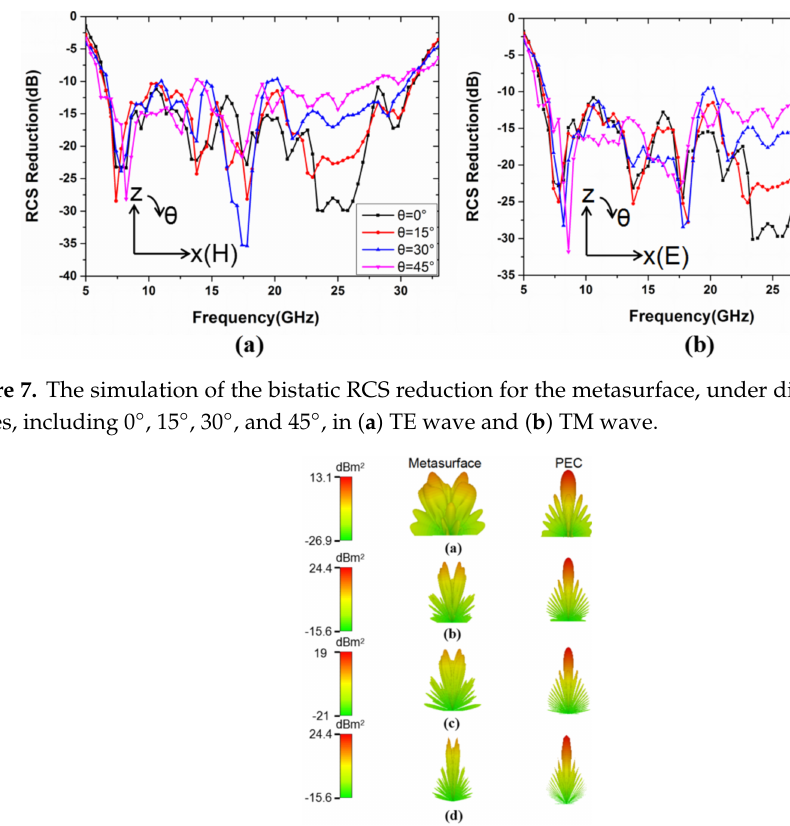
Figure 6. The simulation of the monostatic radar cross-section (RCS) between the metasurface and the equal-sized Perfect Electric Conductor (PEC) under TE and TM wave.